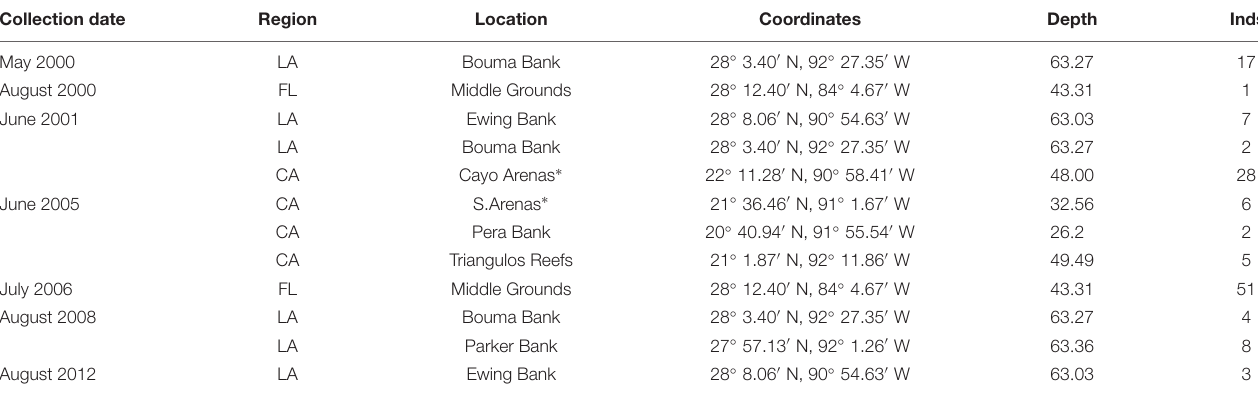
TABLE 1 | Collection information of Botryocladia occidentalis individuals (Inds) used in this study. Region Location